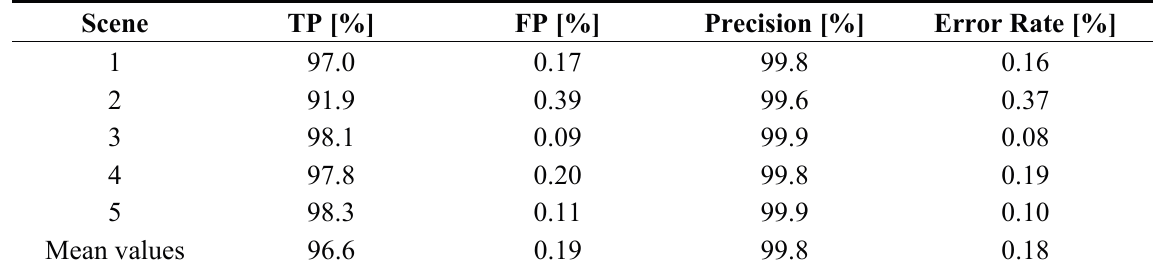
Table 4. Performance evaluation for apples orchard